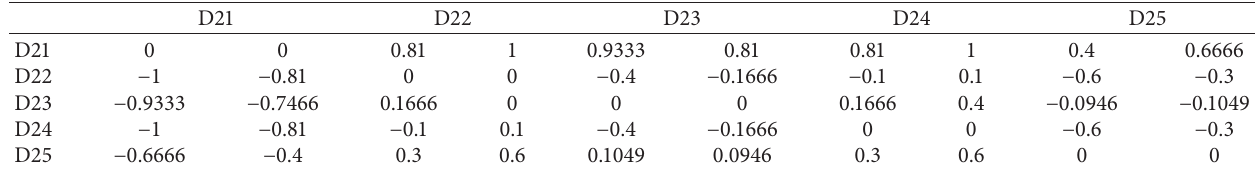
Table 10: Weight matrix before normalization.